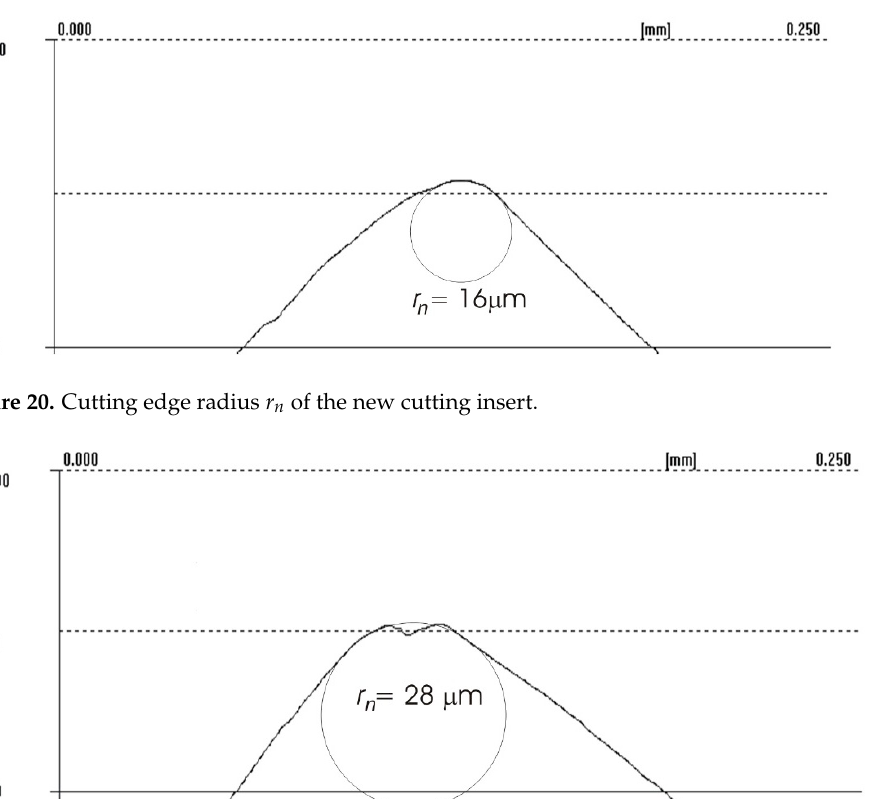
Figure 22. Cutting edge radius r n of the worn cutting insert after longitudinal turning with coolant (36 HRC). Figure 23. Cutting edge radius r n of the worn cutting insert after longitudinal turning without cool- ant (23 HRC).